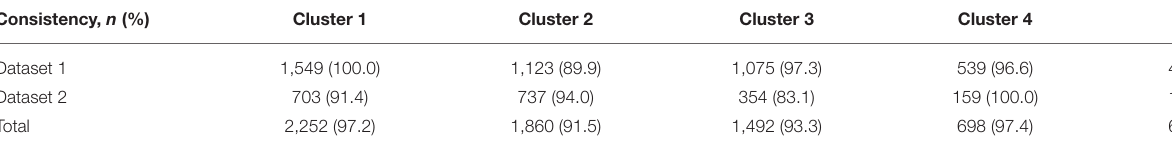
TABLE 2 | The consistency of subtypes by cluster analysis in two independent datasets and total dataset. Consistency, n (%)